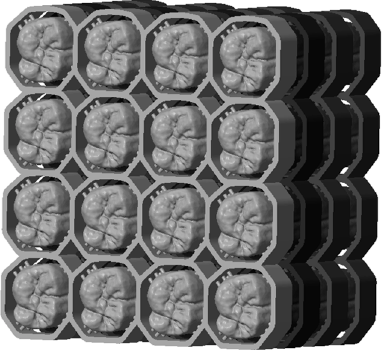
Figure 12. ‘Milling’ support enables stacking and stringing together.